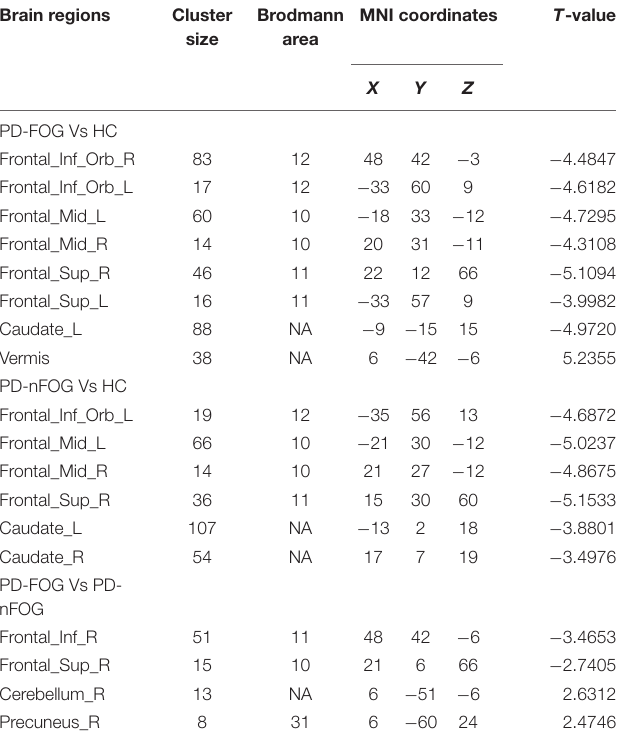
TABLE 3 | Differences in rs-functional connectivity (FC) between PD patients and HCs. Brain regions Cluster